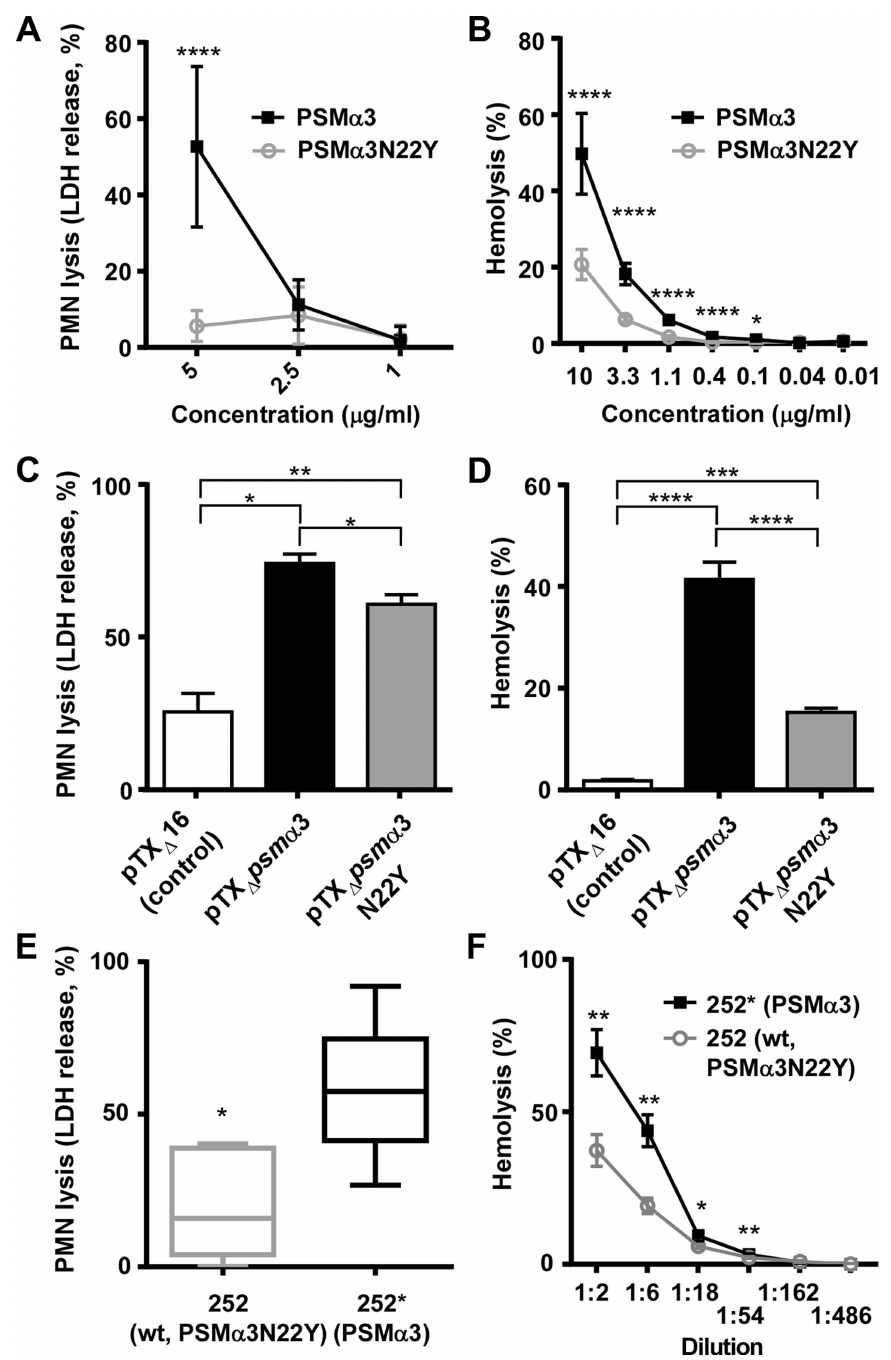
Figure 5. PSM a 3N22Y has diminished cytolytic activities. (A) PMN lysis of synthetic PSM a 3N22Y versus PSM a 3. Data are from 2 donors, measured in triplicate each after incubation at 37 u C for 1 h. At concentrations of 10 m g/ml or higher, both peptides completely lysed the neutrophils. (B) Hemolysis of synthetic PSM a 3N22Y versus PSM a 3. Data are from 2 donors, measured in triplicate, after incubation at 37 u C for 1 h. (C, D) PMN lysis and hemolysis, respectively, of culture filtrates from PSM a 3N22Y- versus PSM a 3-producing strains when expressed on plasmids. pTX D 16 is the empty control vector. The background strain in all constructs is a PSM-free USA300 strain (LAC D psm aD psm bD hld ). Culture filtrates were diluted 1:20 for the PMN lysis and 1:2 for the hemolysis measurements. PMN lysis results are from two and hemolysis data from one donor, with three replicates measured each. (E) PMN lysis of culture filtrates from MRSA252 (252) versus 252*, in which the psm a 3 gene (expressing PSM a 3N22Y) on the genome was changed to express PSM a 3 as present in all non-CC30 strains. The graph shows the results from six different donors. Culture filtrates were diluted 1:10. *, p , 0.05 (paired t-test). (F) Hemolysis of culture filtrates from the same strains as in (E) at different dilutions. (A–F), *, p , 0.05; **, p , 0.01; ***, p , 0.001; ****, p , 0.0001.